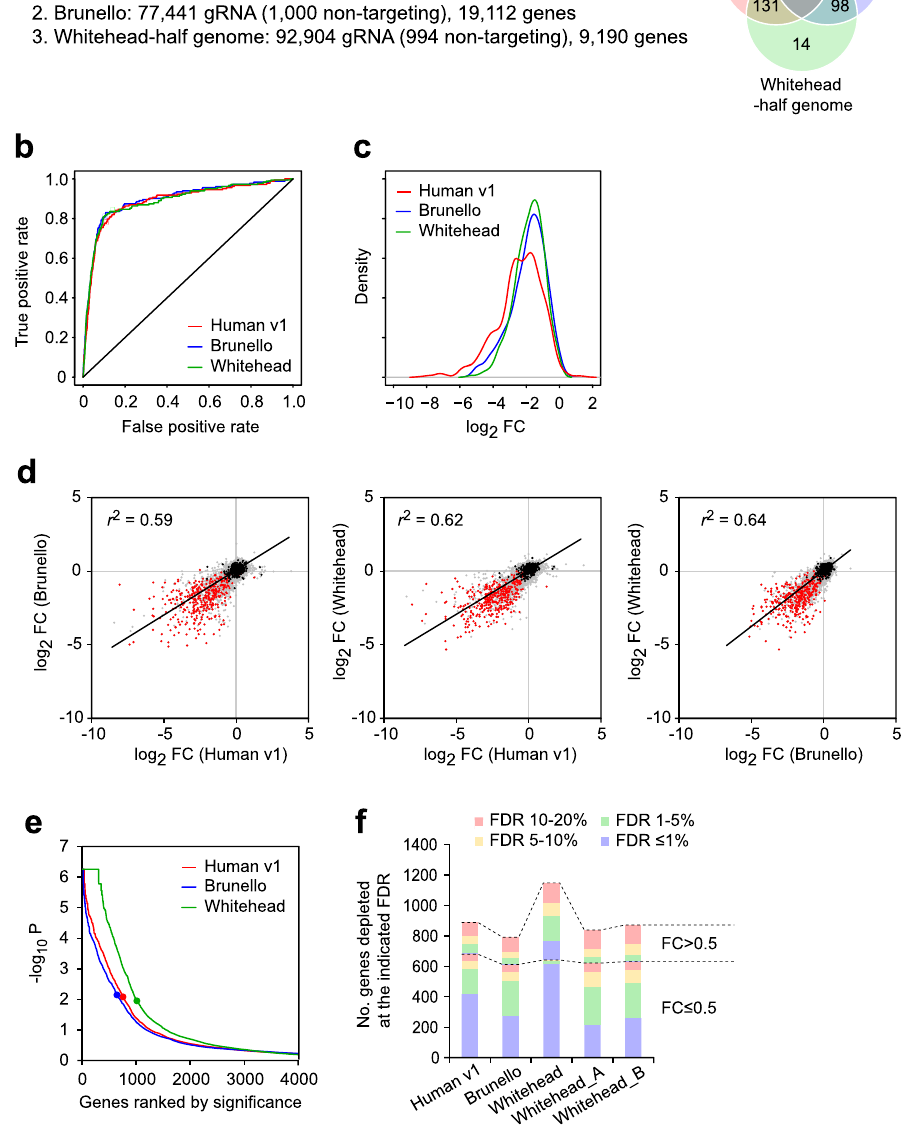
Figure 2. Screening performance of three second-generation CRISPR libraries. ( a ) Schematic showing the screening procedure and the libraries used in this study. ( b ) ROC curves showing the classification performance of the three CRISPR libraries on predefined set of essential and non-essential genes. ( c ) Density functions of gene-level fold change (FC) for 366 essential genes from each library, showing that the Human v1 library exhibits a left shift compared to the other two libraries. ( d ) Pairwise comparison of the gene-level log 2 fold changes of the 8,948 genes analysed. Red and black dots represent the predefined essential and non-essential genes 31 , respectively. Correlation coefficient was shown for each comparison. Similar to c, the Human v1 library exhibits greater FC. ( e ) Plot showing gene rank by significance. ( f ) Number of depleted genes detected at the indicated FDR and FC by each library. The Whitehead library was also separated into two subsets denoted with suffix _A and